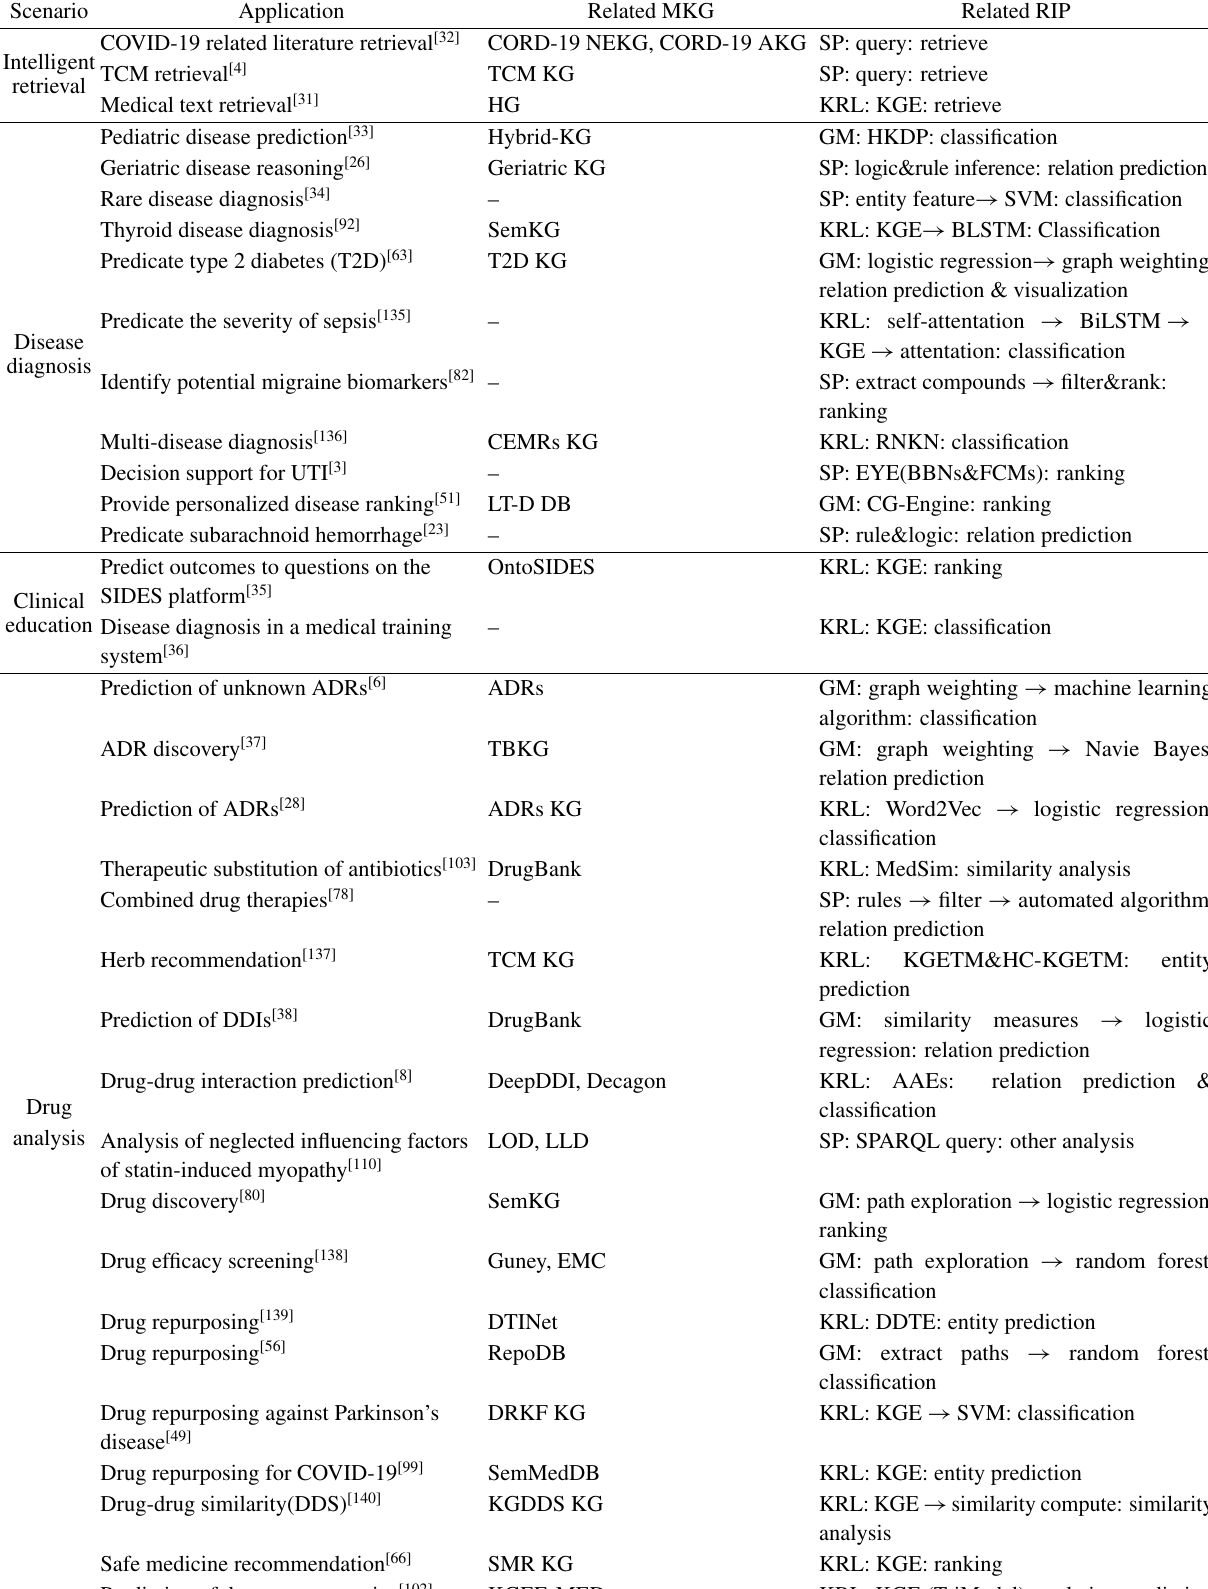
Table 3 Intelligent applications based on MKG and